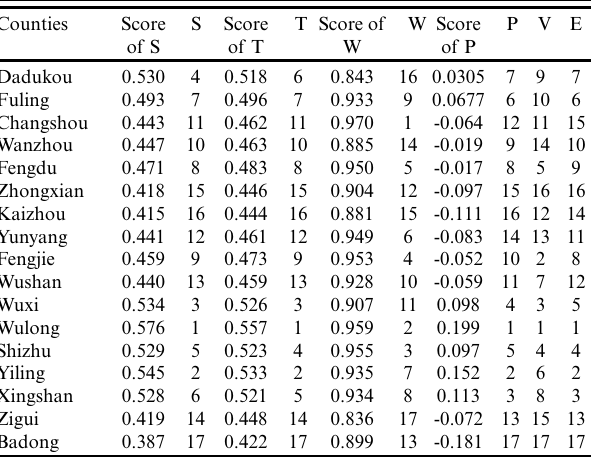
Table 6 . Disaster resilience ranking calculated using the entropy method.